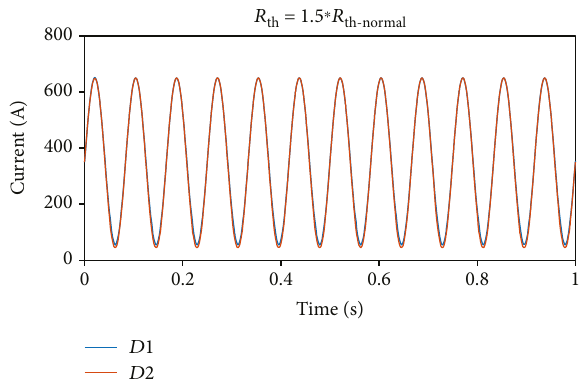
Figure 2: Currents of parallel-connected power modules ( D 1 aged to 1 5 ∗ R th − normal ).